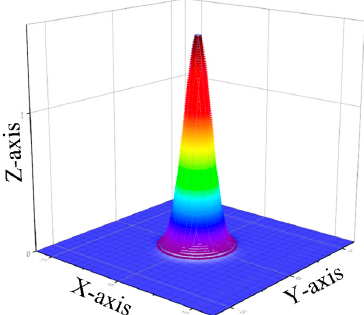
Figure 4. Schematic illustration of the planar Gauss heat source model.